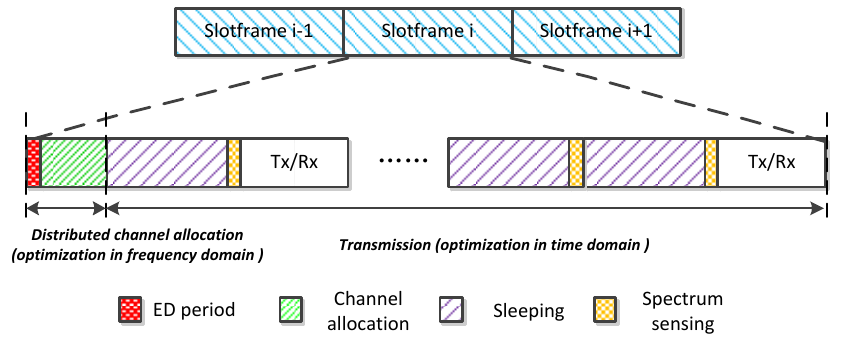
Figure 2. Transmission structure of the node .